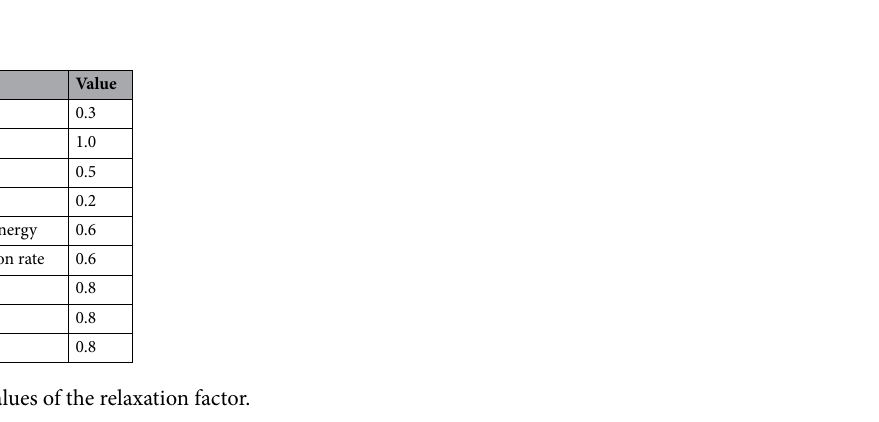
Table 7. Boundary conditions of the vent.